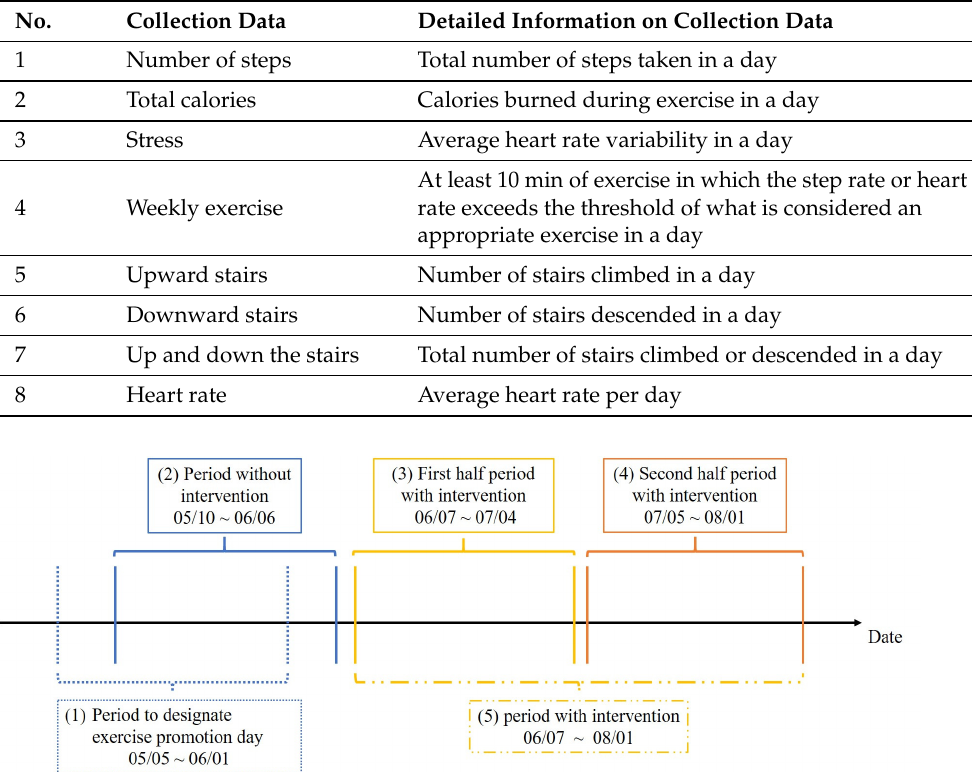
Figure 2. The duration of this